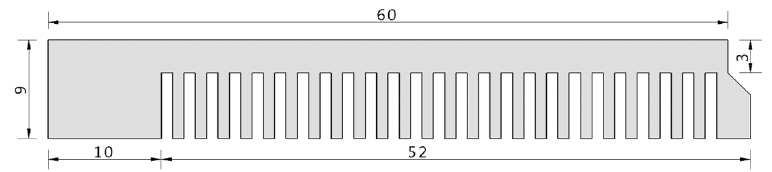
Figure 1. Cantilever geometry used for distortion study (dimensions in mm).